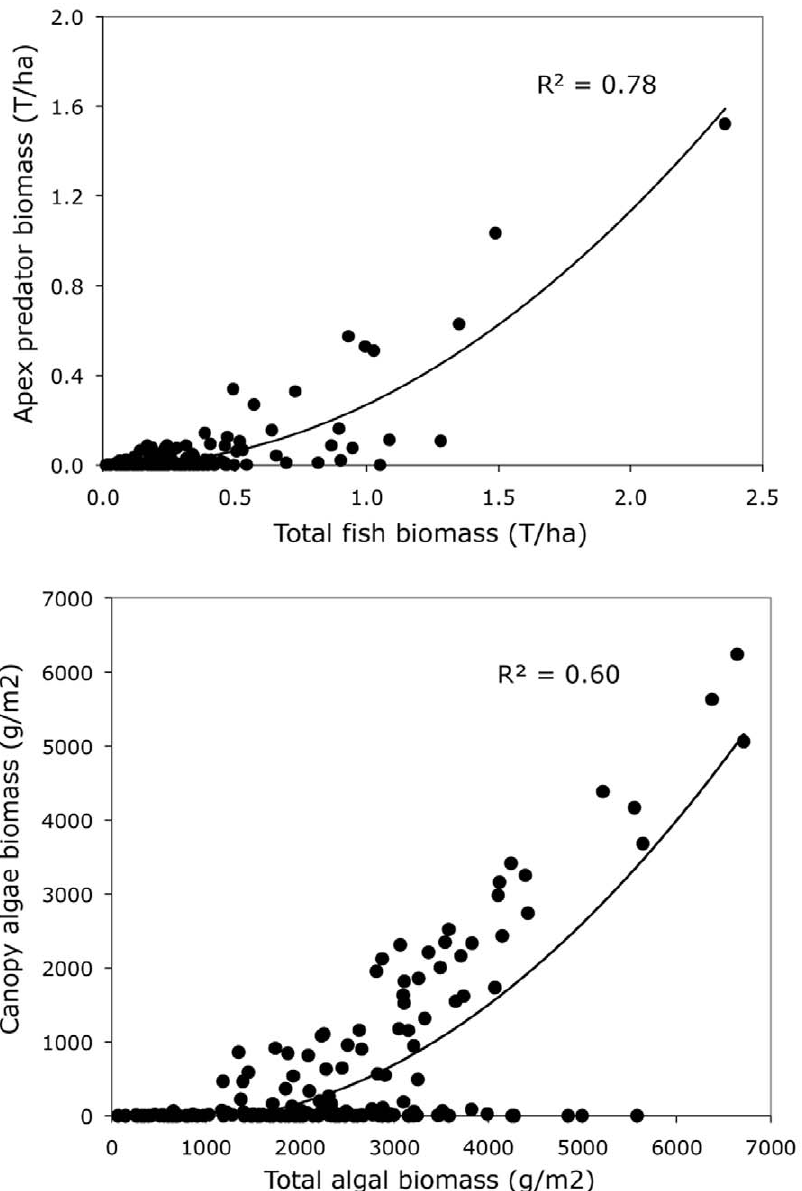
Figure 5. Top: Relationship between total fish biomass and biomass of apex predators. Bottom: Relationship between total biomass of algae and biomass of canopy algae (Fucales). Sites with no Fucales above 2000 g m 2 2 are found in the NW Mediterranean.